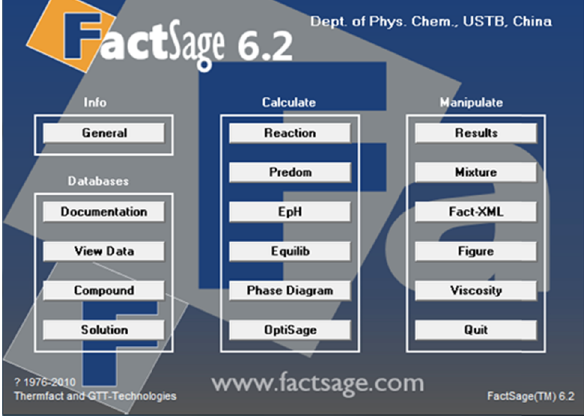
Figure A1: Module selection for calculating melting temperature.